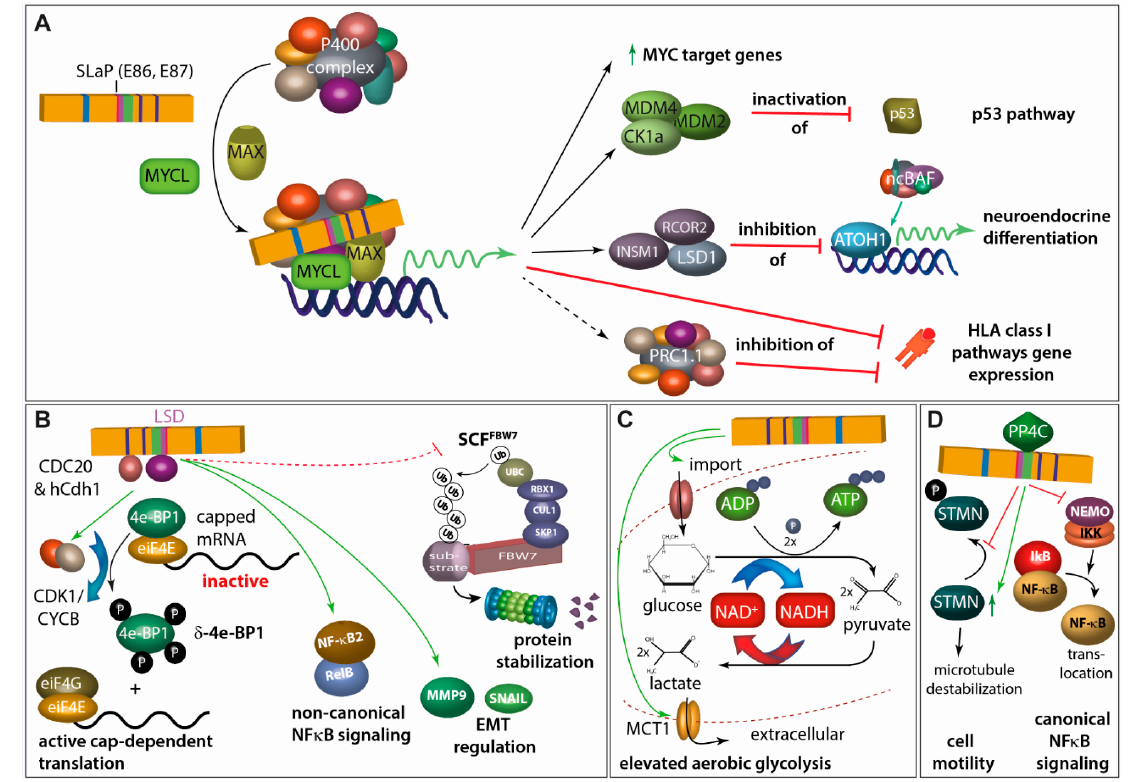
Figure 4. A pleiotropy of functions has been described for sT. ( A ) Via the SLaP binding domain, sT can recruit the transcription factor L-MYC and its heterodimerization partner MAX to the P400 transcriptional regulatory complex. This leads to (i) a general upregulation of MYC-target genes, (ii) inactivation of p53 by increased expression of MDM2 and the MDM4-activator CK1alpha, (iii) expression of LSD1 and other CoREST complex members which in turn repress expression of ATOH-1- and non-canonical BAF (ncBAF) complex-driven expression of genes involved in neuroendocrine differentiation, and (iv) repression of genes involved in HLA class I antigen presentation either directly or through the polyocomb repressive complex 1.1 (PRC1.1) [68,83–85]. ( B ) MCPyV sT is a promiscuous E3 Ligase inhibitor. By interacting with cdc20 homolog 1 (Cdh1; hCdh1) E3 ligase adapter and through the LT stabilizing domain (LSD) with CDC20, cyclin-dependent kinase 1/cyclin B1 (CDK1/CYCB1) is activated which leads to hyperphosphorylation of eukaryotic initiation factor 4E (eIF4E)-binding protein (4E-BP1) translating into active cap-dependent translation and increased cell mitogenesis. This effect is contributing to the transforming capacity of sT [42,86]. Moreover, through its LSD domain, sT activates non-canonical NFkB signaling both by inducing increases in NFkB2 and RELB transcription and also by promoting NFkB2 stabilization and activation [81]. In this regard, LSD-mediated interaction of MCPyV sT with different E3 ligases, possibly including FBW7, stabilizes a multitude of different proteins [80,87,88]. For example, this interaction stimulates differential expression of epithelial–mesenchymal transition (EMT)-associated genes such as MMP-9 and Snail [82]. ( C ) sT expression can profoundly impact expression of metabolic pathway genes, especially those involved in glycolysis. Indeed, the expression of two glycose transporters GLUT1 and GLUT3, and the major monocarboxylate transporter for lactate and pyruvate, MCT1, is increased upon sT expression in fibroblasts [89]. ( D ) sT impacts cell motility, partially by interacting with PP4C leading to upregulation of stathmin (STMN)-mediated microtubule destabilization as well as to remodeling of the actin cytoskeleton mediated by dephosphorylation of β 1-integrin [90–92]. Moreover, PP4C and sT interaction seems to allow repression of the NF κ B essential modulator (NEMO), an adaptor protein inhibiting I κ B kinase α (IKK α )/IKK β -mediated I κ B phosphorylation and thus limiting NF κ B translocation into the nucleus